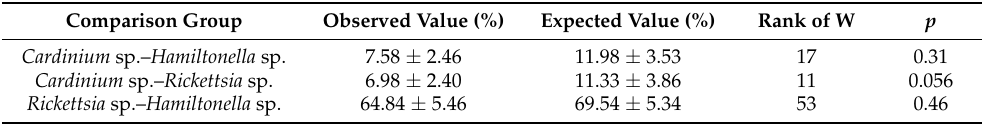
Table 1. Expected frequency of coinfection based on observed frequencies of the infections compared in each sample.